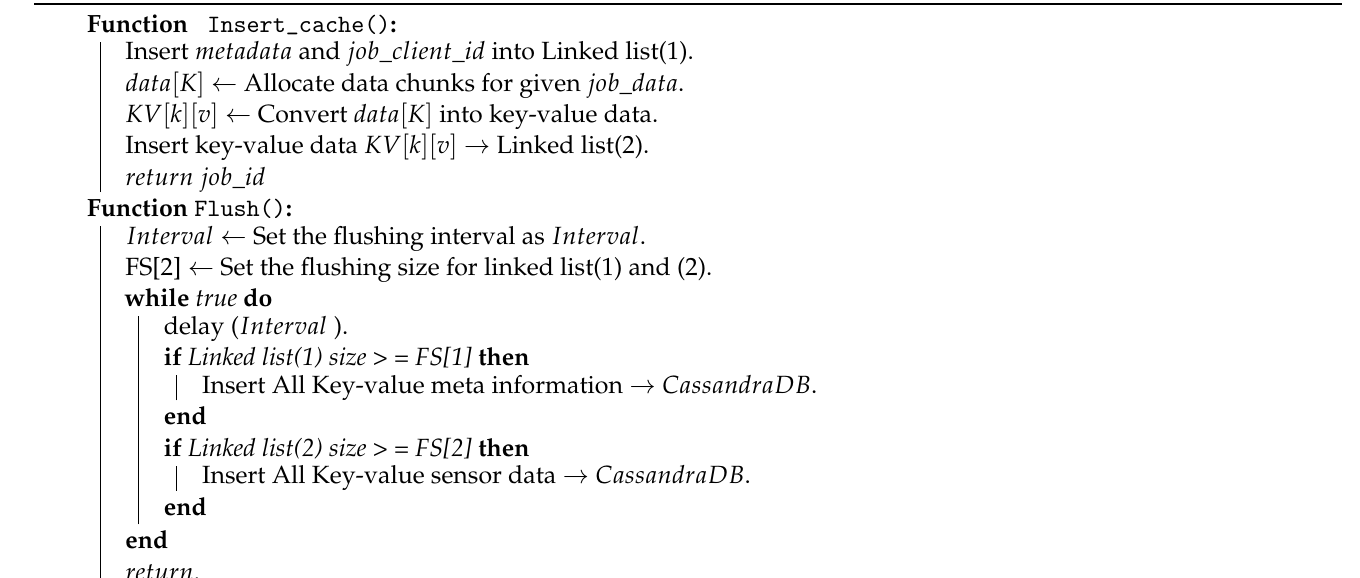
Algorithm 3: Data scheduling in Insert_cache function